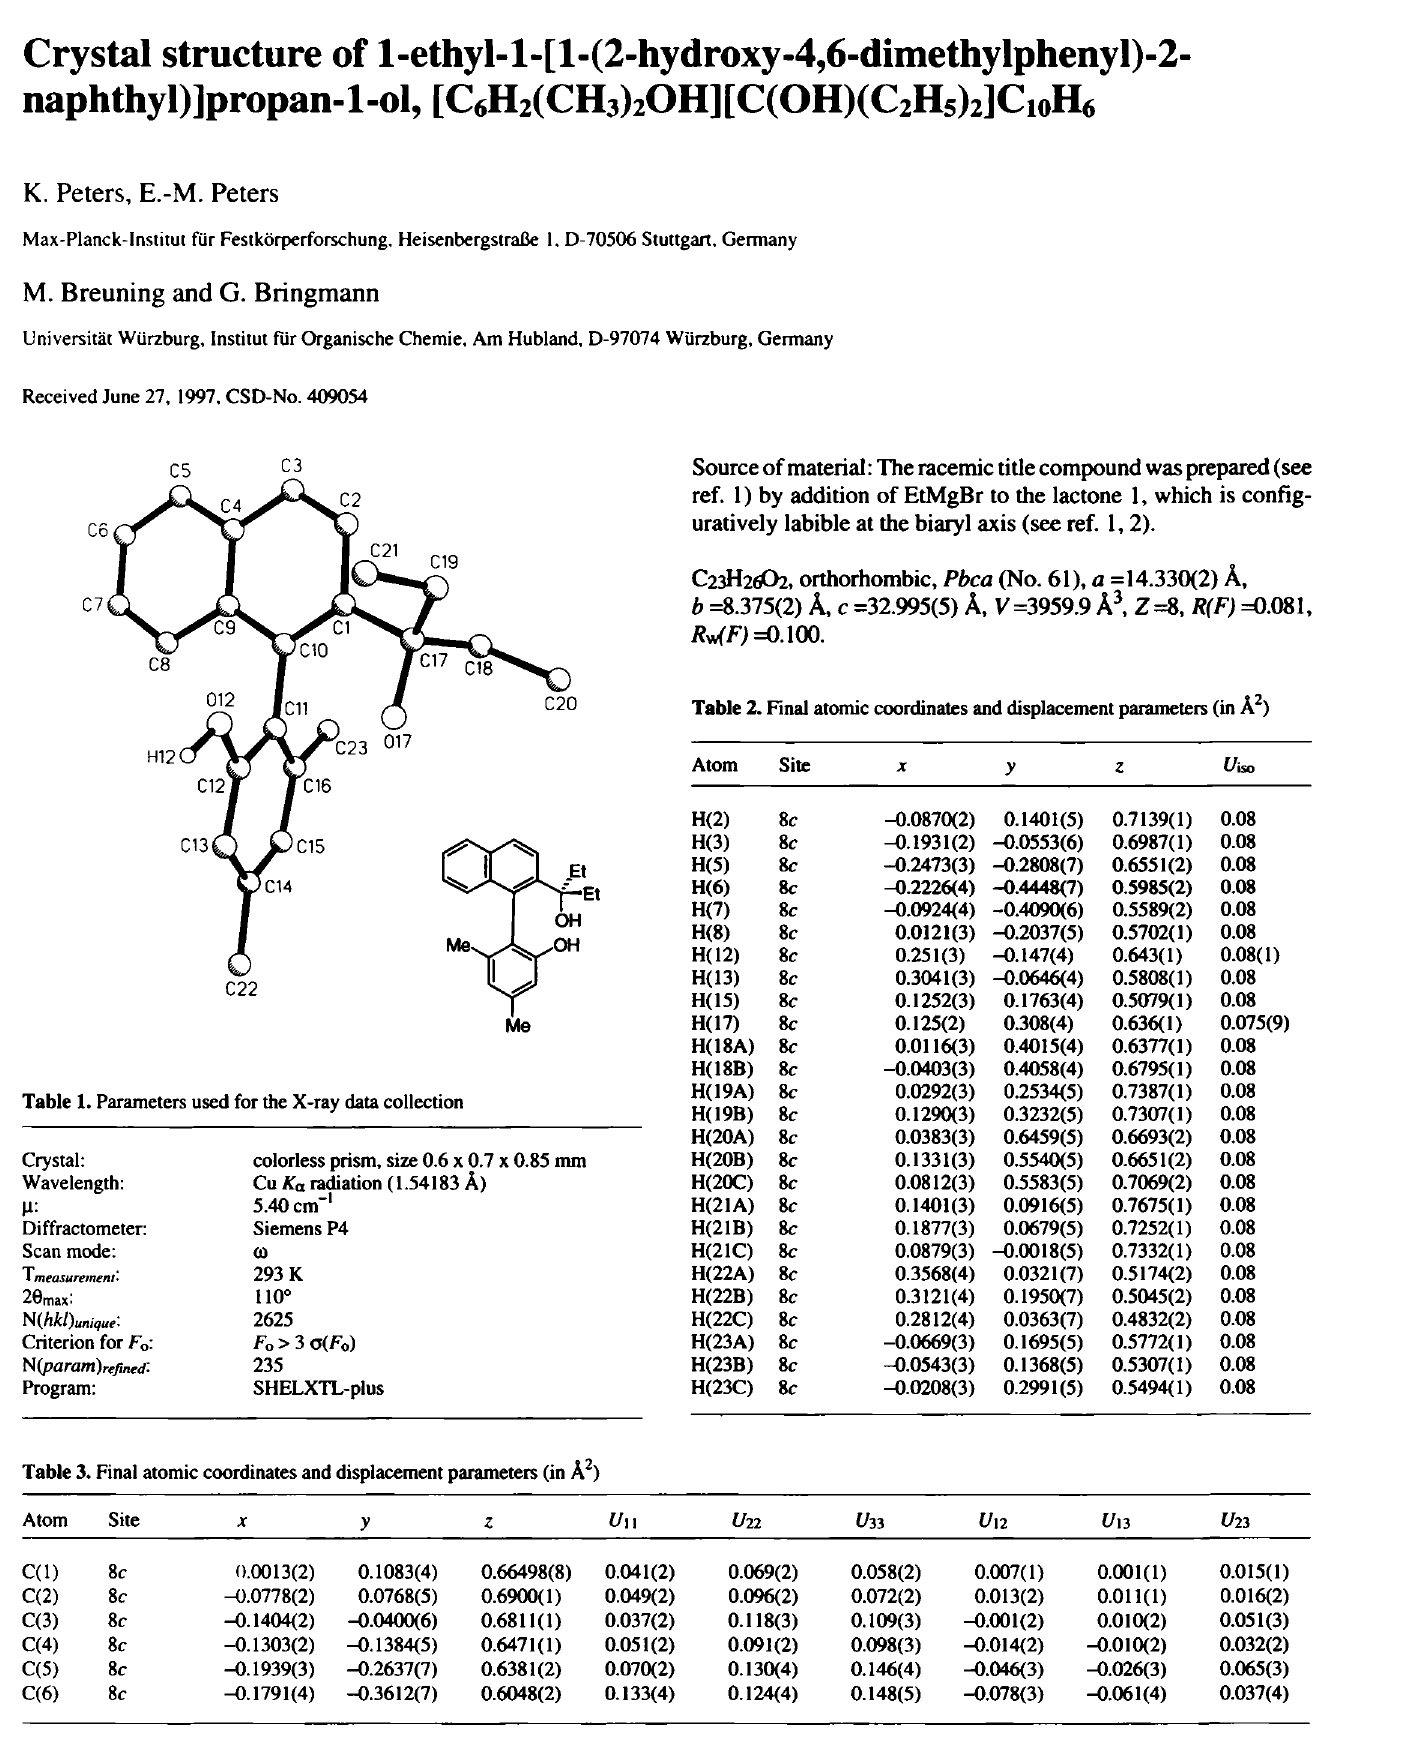
Table 3. Final atomic coordinates and displacement parameters (in A^) Atom